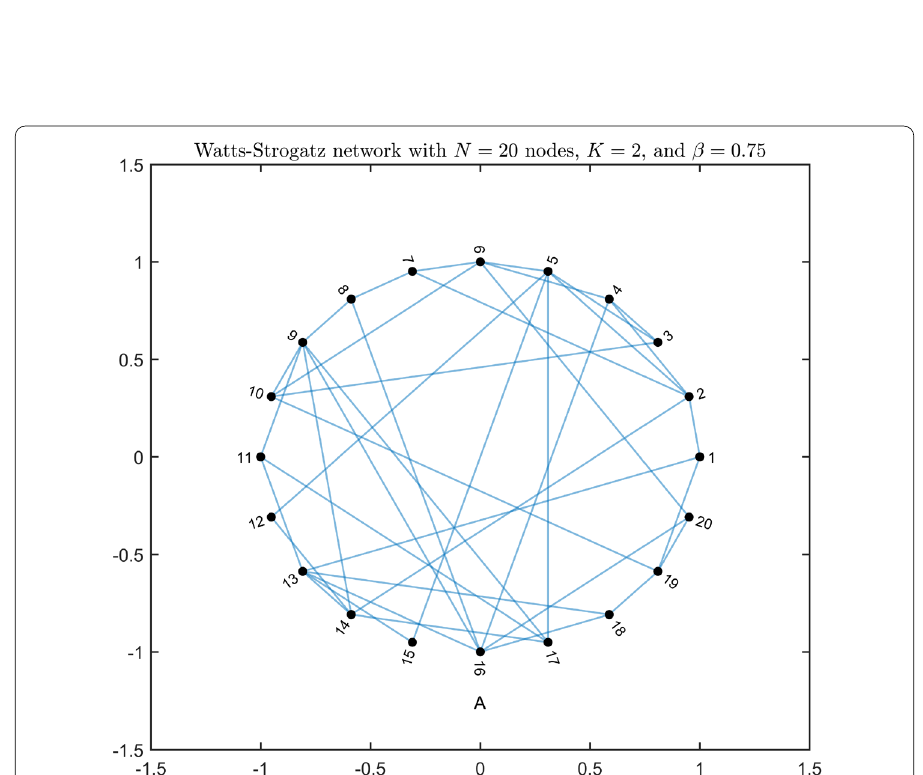
Figure 13 The topology structure of Watts-Strogatz complex network with N = 20, K = 2 and β =